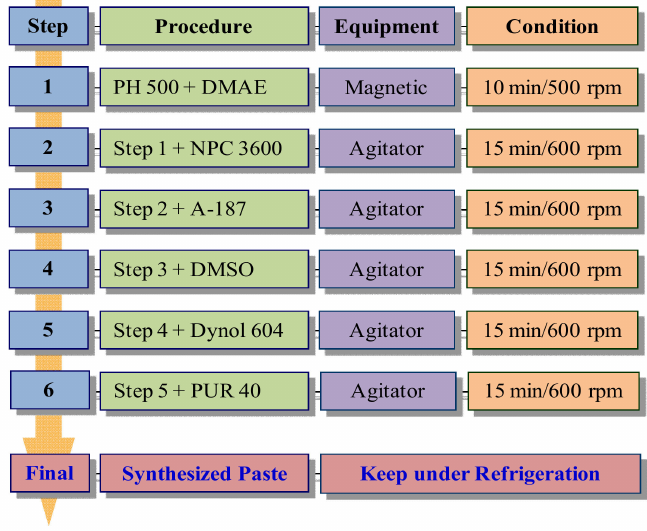
Figure 2. Synthesis formulation of conductive paste.